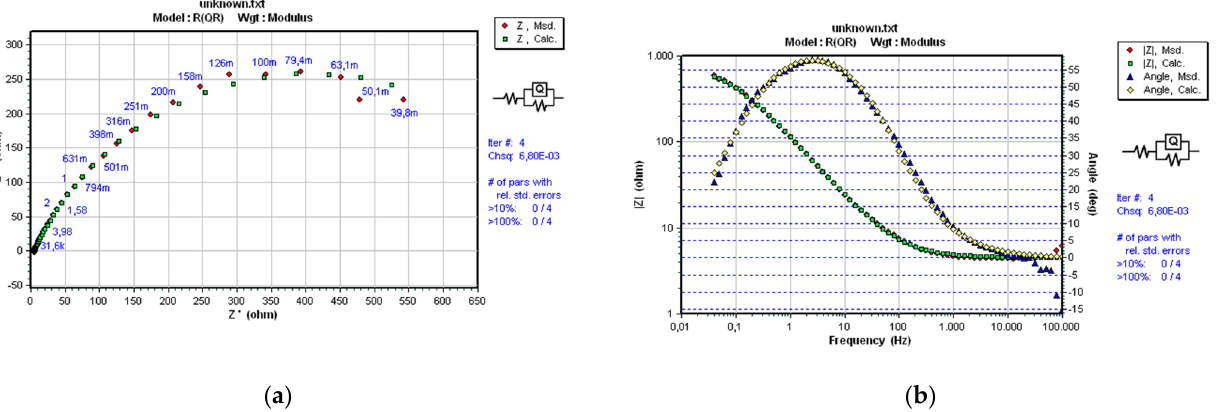
Figure 9. Nyquist ( a ) and Bode ( b ) plots of WC-10Co.